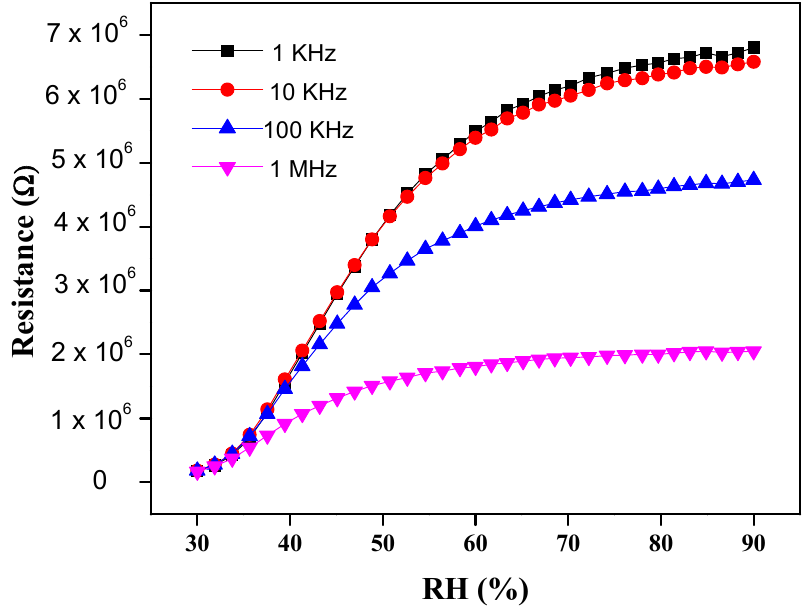
Figure 3. Resistivity response of PEO–CuO–MWCNT: 1% nanocomposite at different % RH.